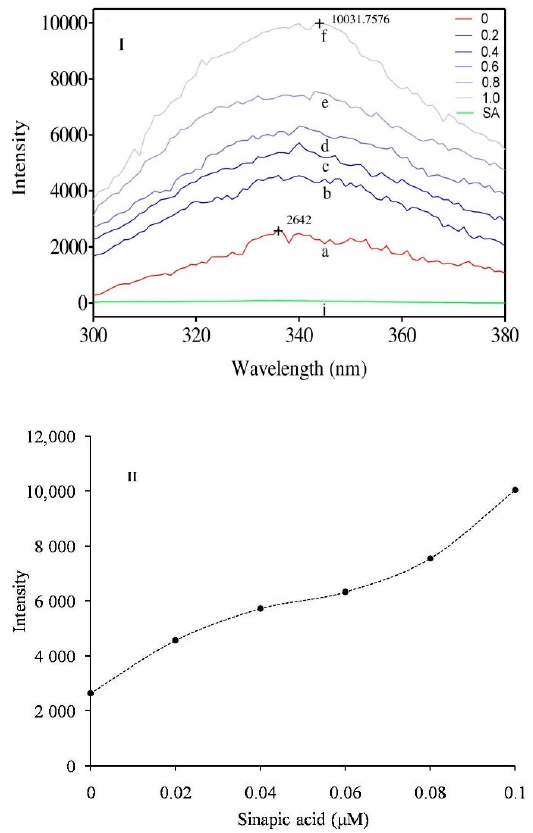
Figure 7. Intrinsic fluorescence spectra of sPLA2-IIA enzyme: ( I ) Fluorescence spectra of sPLA2-IIA enzyme (20 µ g/mL) alone (a), with sinapic acid concentrations of 0.02 µ M (b), 0.04 µ M (c), 0.06 µ M (d), 0.08 µ M (e) and 0.1 µ M (f). ( II ) The graph showed maximum fluorescence intensity of sPLA 2 -IIA enzyme of each concentration of sinapic acid.